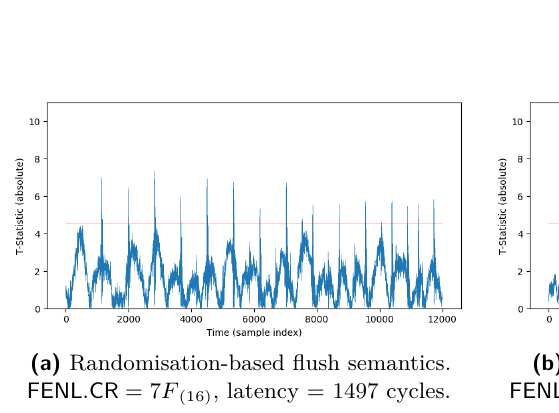
Figure 8: Results for experiment 3, relating to leakage from Figure 4 as executed on the PicoRV32. Note that the t-statistic is plotted in absolute form; the plots are cropped wrt. the target kernel, which has a longer latency post -insertion of fence instructions.